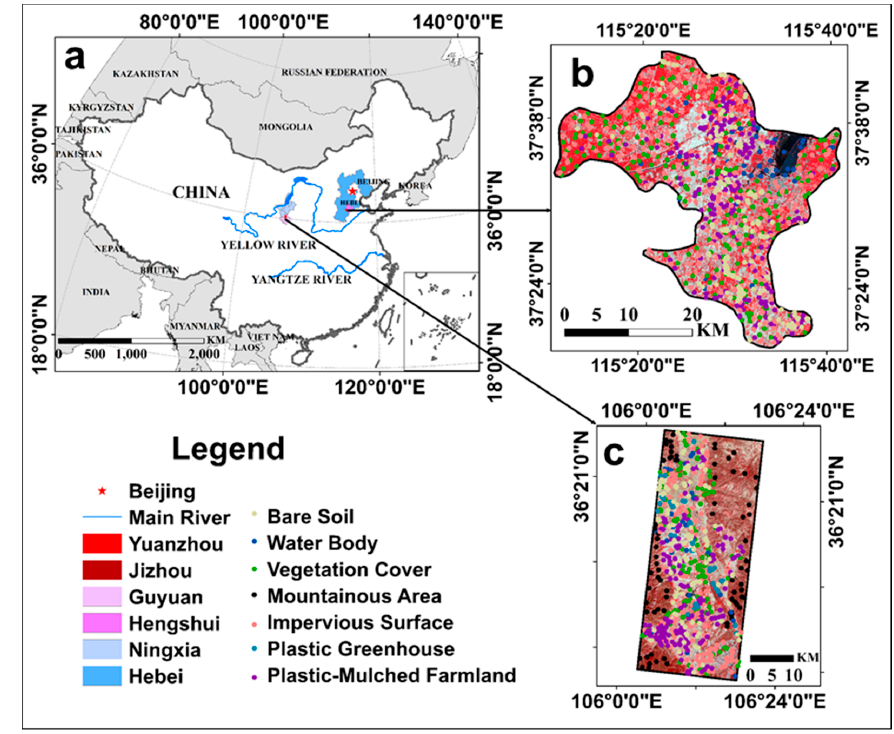
Figure 2. ( a ) The locations of the two study areas; ( b ) the study area of Jizhou (Landsat-8 OLI (Operational Land Imager) image, display composite: R = near-infrared, G = red, B = green); and ( c ) the study area of Guyuan (Landsat-8 OLI image, display composite: R = near-infrared, G = red, B = green).